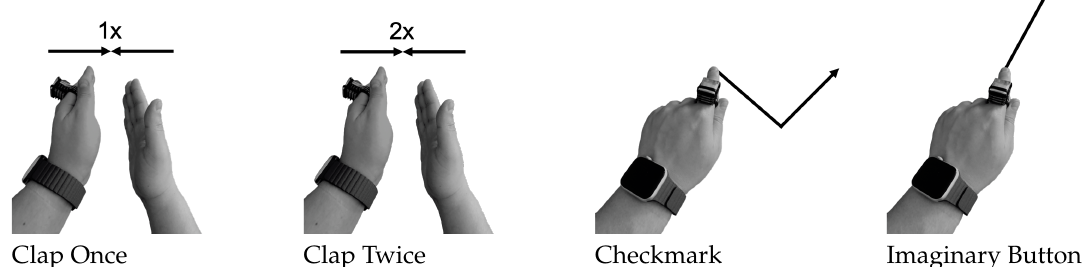
Figure 7. Gestures based on high acceleration values along the Z-axis, multiple directions in the YZ-plane or direction information along the X-axis.